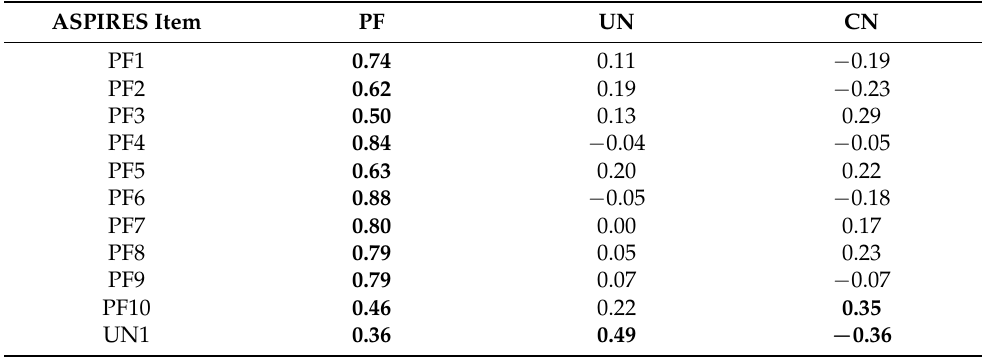
Table 3. Factor loadings from a principal components analysis with an orthogonal Procrustes rotation of Time 1 ASPIRES